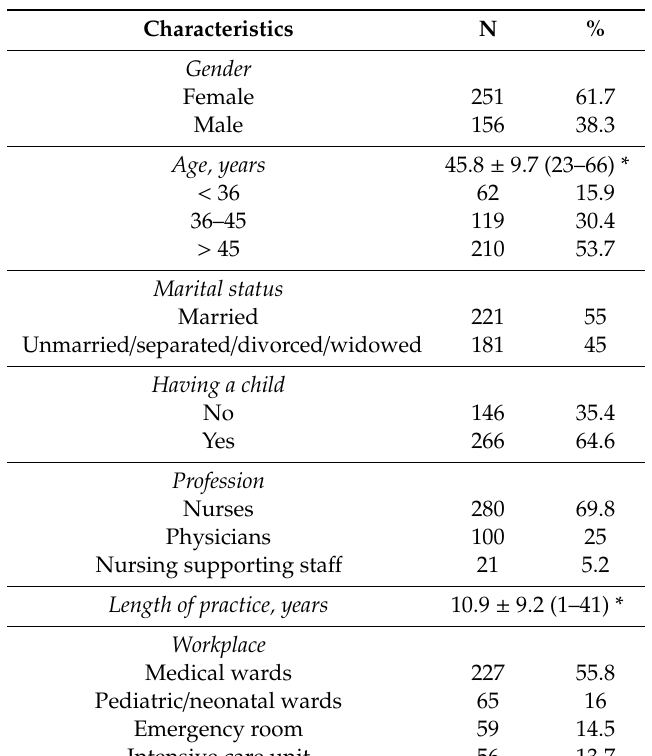
Table 1. Participants’ socio-demographic and professional